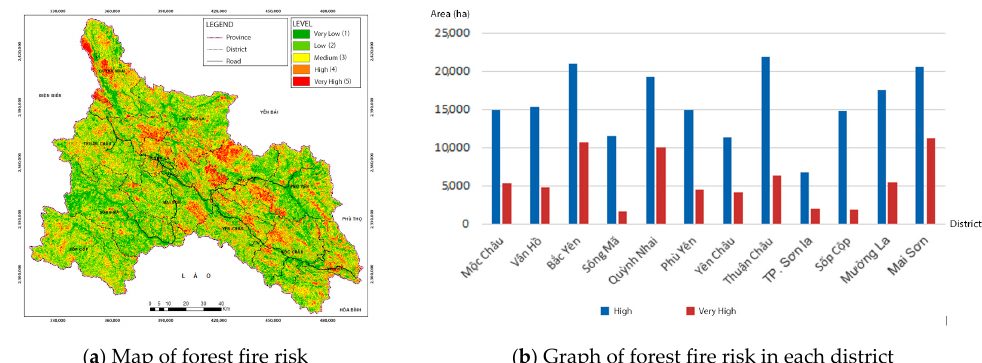
Figure 7. ( a ) Map of the forest fire risk in Son La province and ( b ) the fire risk plotted per district. Table 4. Comparison of the forest fires between 2011 and 2015 in Son La Province and the forest fire risk map.